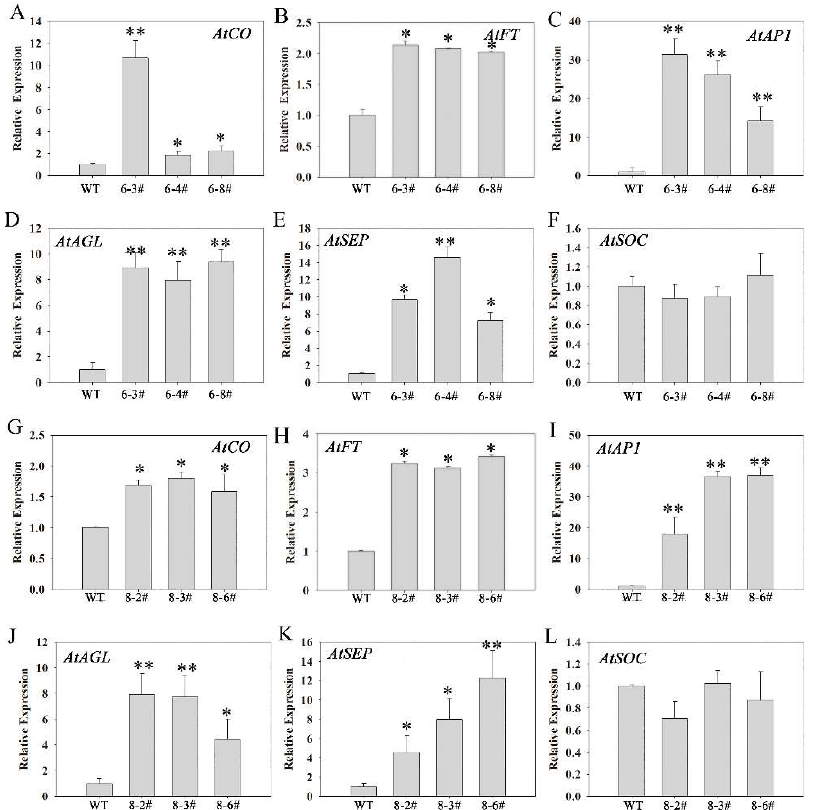
Figure 10. Analysis of the expression patterns of flowering time-related genes in regulated PtoNF- YC6 and PtoNF-YC8 transgenic Arabidopsis . ( A – F ) represent the expression levels of AtCO, AtFT, AtAP1, AtAGL, AtSEP and AtSOC in PtNF-YC6 transgenic Arabidopsis , respectively. ( G – L ) represent the expression levels of AtCO, AtFT, AtAP1, AtAGL, AtSEP and AtSOC in PtNF-YC8 transgenic Arabidopsis, respectively. * ( p < 0.05) and ** ( p < 0.01) indicate significant differences.